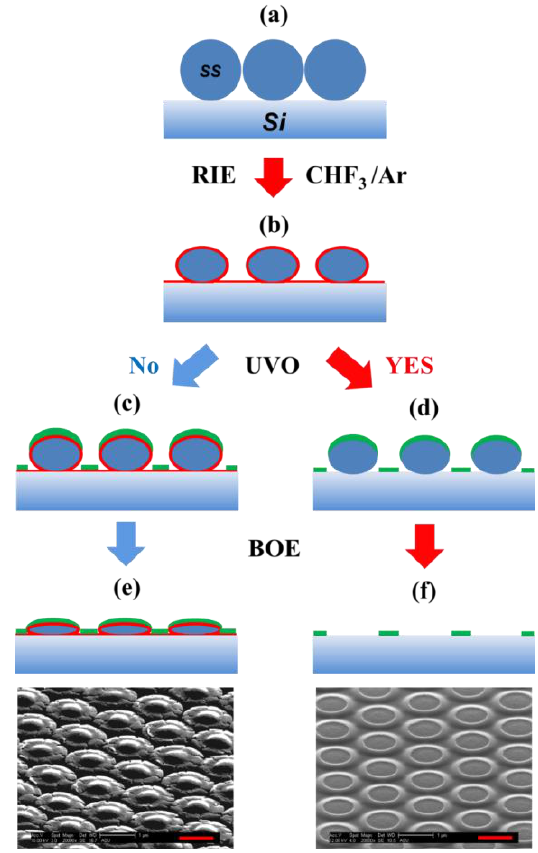
Figure 5. ( a – f ) Schematic illustration of ultra-violet ozone (UVO) treatment effect on SS removal after RIE. (Green-line indicates deposited Cr layer, and red-line for SiC x F y passivating layer formed during RIE process, scale-bar = 1 μm).